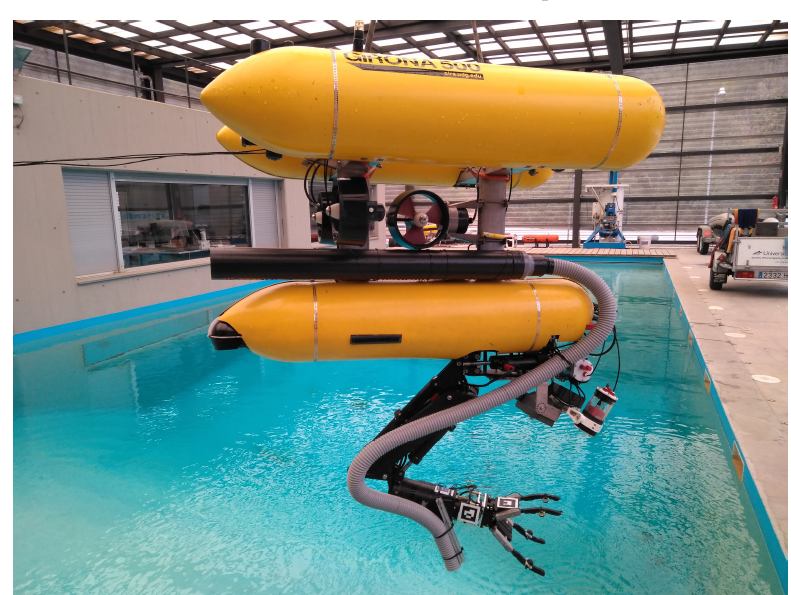
Figure 2. TWINBOT overall description.